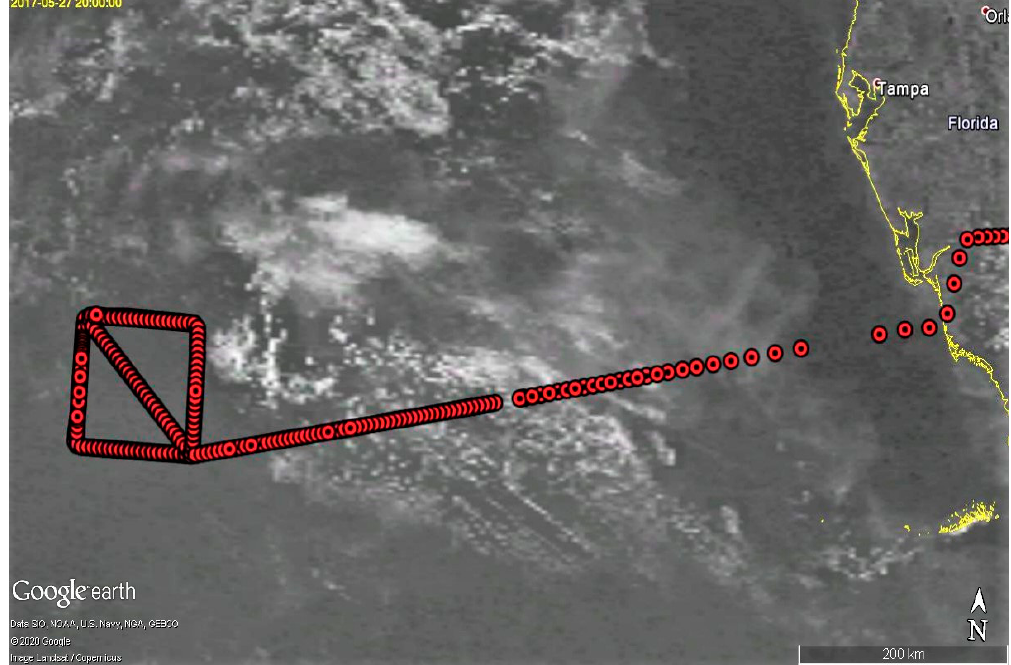
Figure 13. DC-8 and DAWN flight track over budget box in central GoM on 27 May 2017 with GOES-13 VIS imagery at 2000Z (the beginning of the first box) (Google Earth).